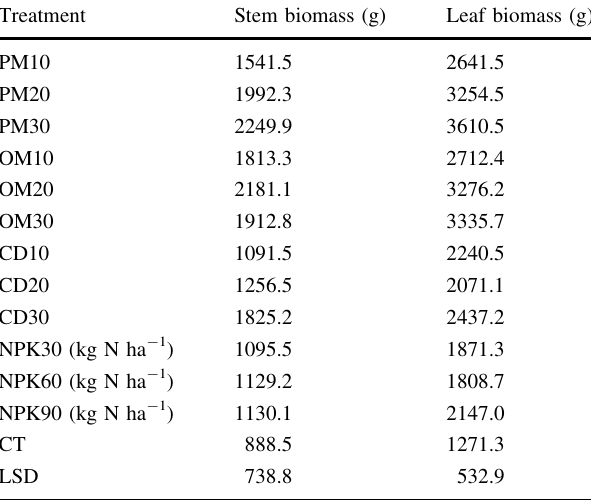
Table 4 Effects of different sources and rates of NPK and organic fertilizers on leaf and stem biomass of Moringa